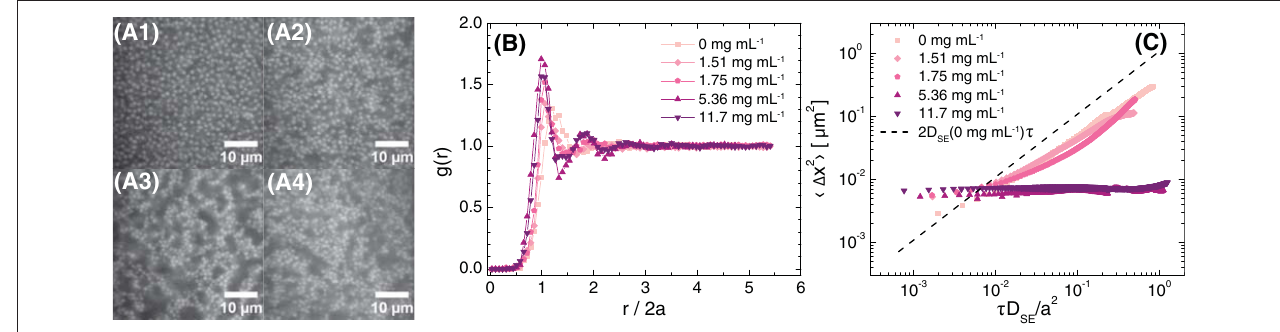
FIGURE 6 | (A) Confocal micrographs at z = 30 µ m (brightness/contrast adjusted), (B) radial distribution function as a function of normalized distance from the particle center, and (C) 1-dimensional mean-squared displacement as a function of non-dimensionalized delay time τ D SE / a 2 for φ ≈ 0.30 suspensions in 80 (w/w)% glycerol in water, 20.0 ± 0.6 mM NaCl, and various concentrations of polyacrylamide in the free volume. The polyacrylamide concentrations in the free volume are (A1) 0 mg mL − 1 , (micrograph not shown) 1.51 mg mL − 1 , (A2) 1.75 mg mL − 1 , (A3) 5.36 mg mL − 1 , and (A4) 11.7 mg mL − 1 . The dashed line in (C) is the MSD calculated for Stokes-Einstein diffusion in 80 (w/w)% glycerol in water with 20 mM NaCl. The actual volume fraction of the sample with 5.36 mg mL − 1 polyacrylamide was φ = 0.29.